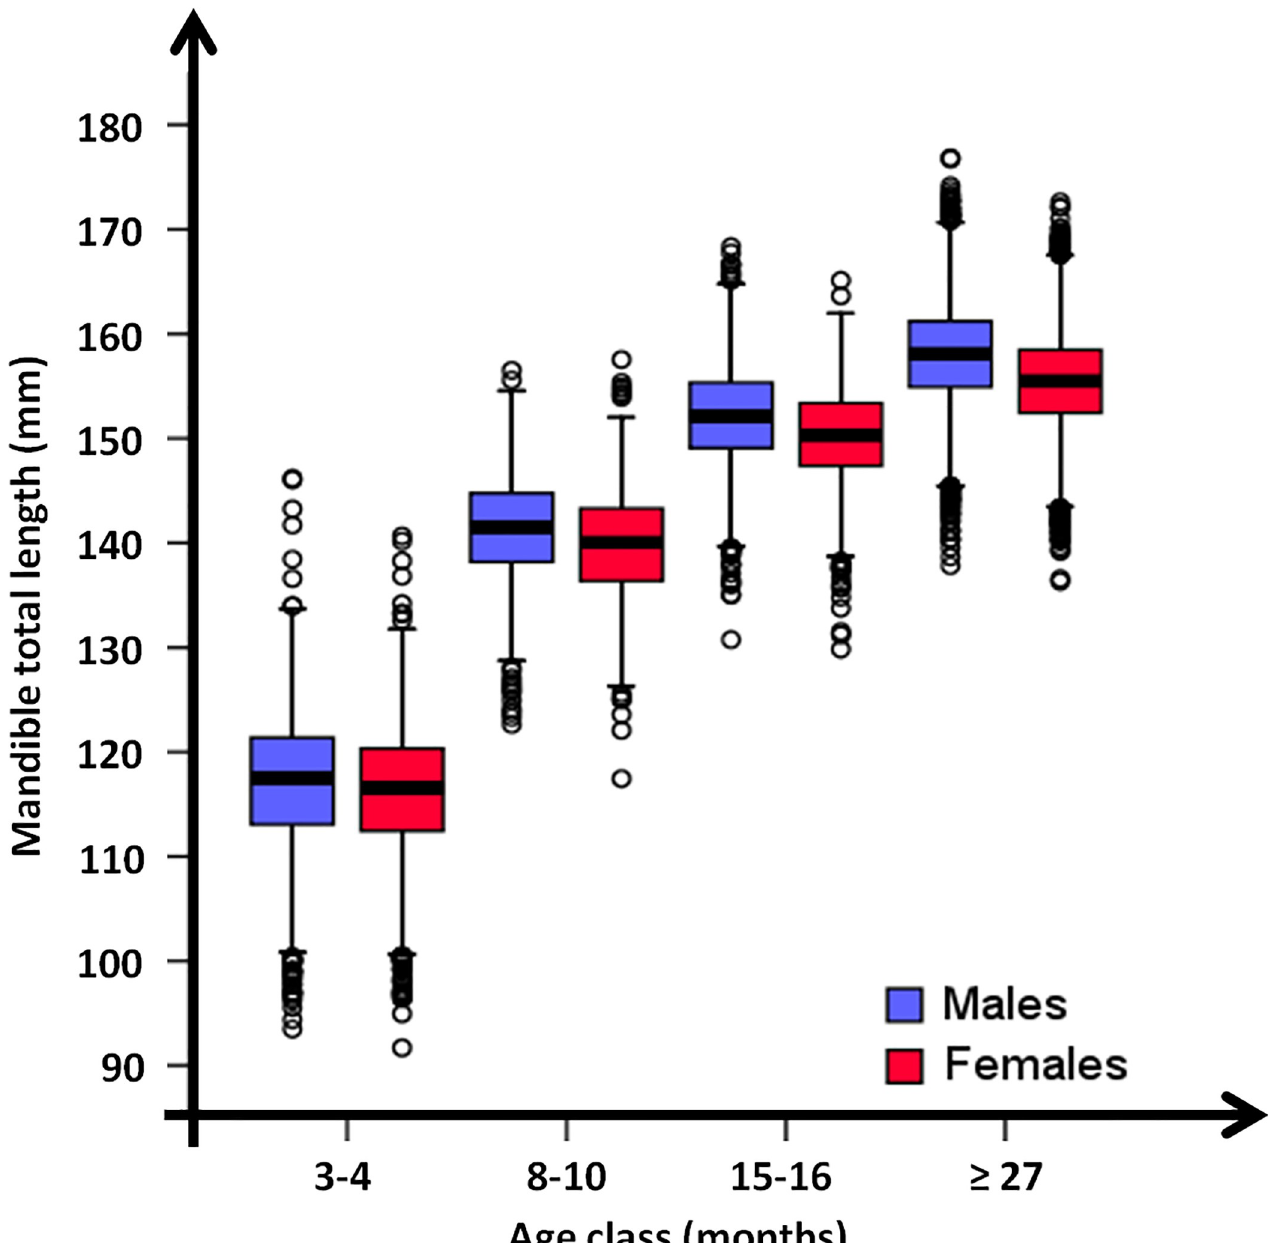
Fig 2. Mandible growth. Mandible total length in relation to the age class of 24,972 roe deer (12,026 females and 12,946 males) legally shot during the annual harvest (August 1 st -September 30 th and January 1 st -March 15 th ) from 2005 to 2015 in Arezzo province (Tuscany, Central Italy).